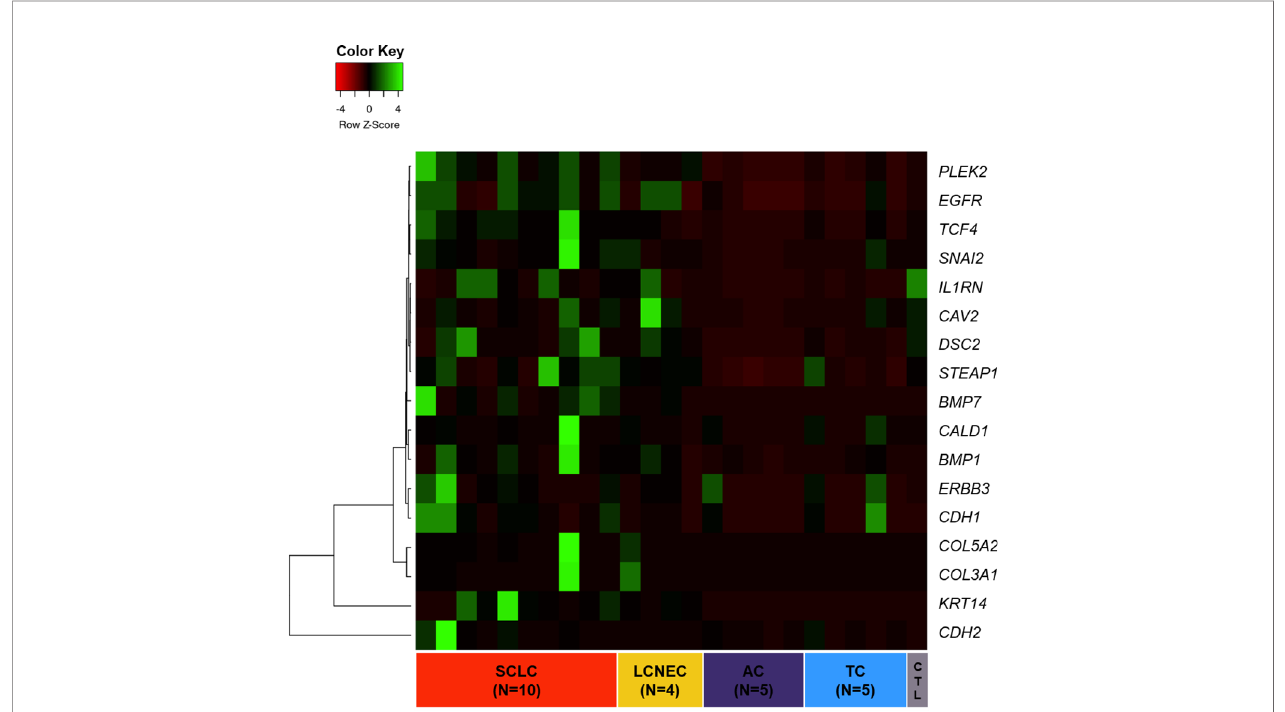
FIGURE 1 | Heatmap of 17 EMT-related genes differentially expressed across PNET histological